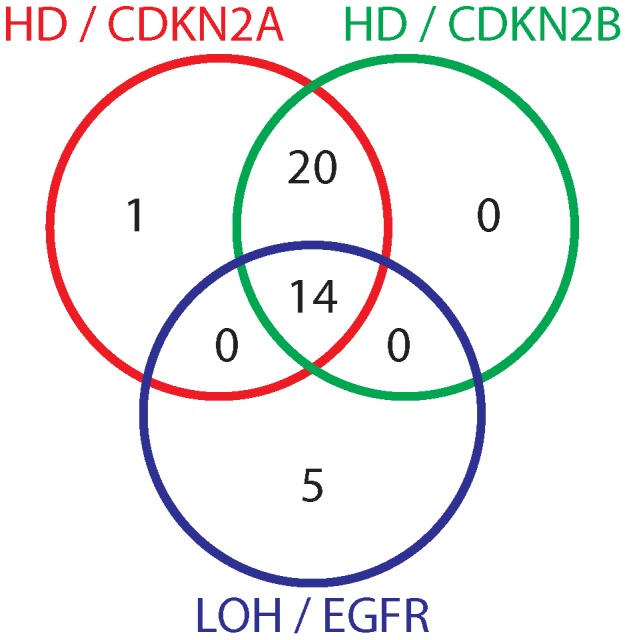
Overlap of genomic events among patients harboring risk allele at rs1015793.Venn diagram of patients that were homozygous for the risk allele at rs1015793, and displayed aberrations at EGFR and CDKN2A/B.